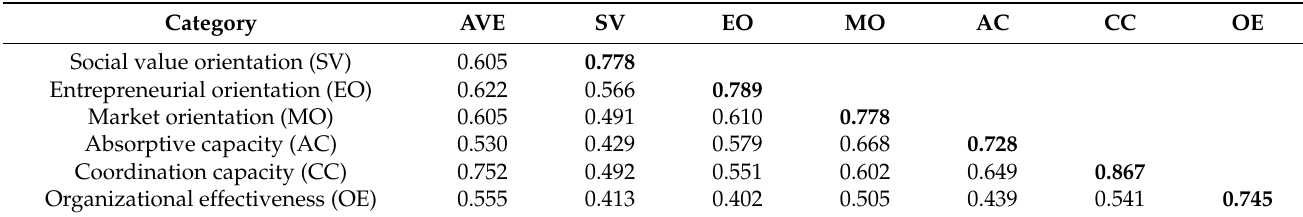
Table 4. Discriminant